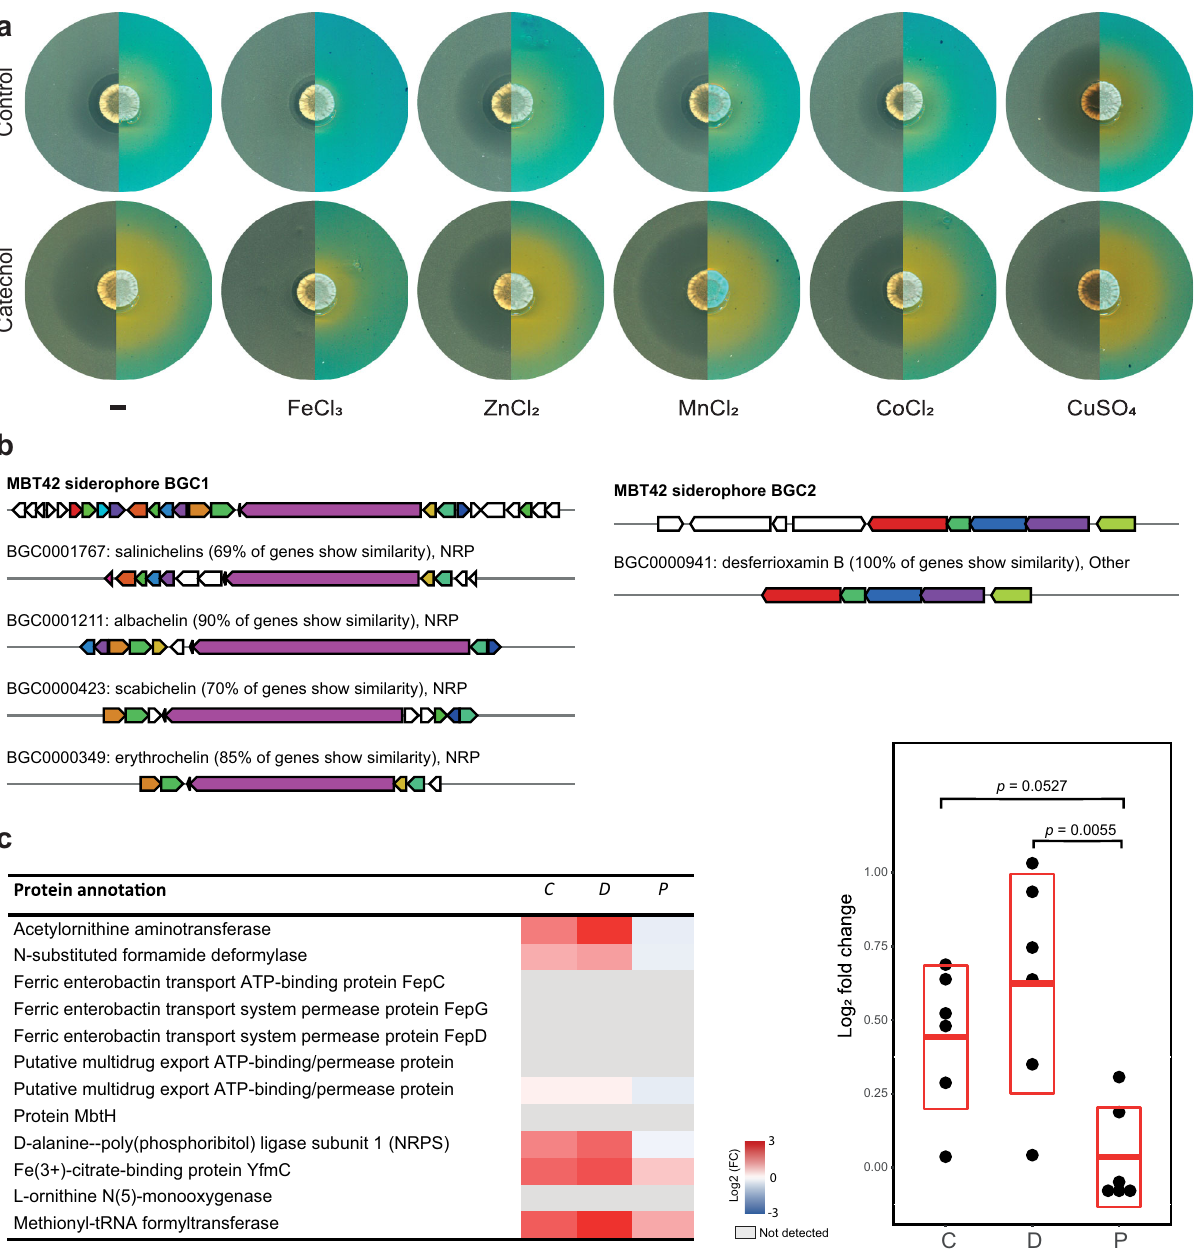
Fig. 2 Catechols elicit siderophore production by Streptomyces sp. MBT42. a Streptomyces sp. MBT42 was grown on NA with and without 100 µ M catechol, supplemented with various metal salts (5 µ M) ( n = 3). After 4 days of growth, plates were overlaid with B. subtilis (left) to test for antimicrobial activity or with CAS agar to detect the extracellular production of iron-chelating molecules (orange halos; right). Note that catechol inhibits the growth of B. subtilis and induces siderophore production, and that these zones are highly comparable. When iron was added to the medium, siderophore production was almost completely inhibited and the semi-transparent halo was no longer visible. b Analysis using antiSMASH revealed two siderophore BGCs in the genome of MBT42. KnownClusterBlast output from antiSMASH which shows similar clusters from the MIBiG database. Genes marked with the same color are interrelated; white genes have no relationship. c Change in protein expression of the salinichelin-like BGC of Streptomyces sp. MBT42 in response to catechin (C), dopamine (D), and phenylephrine (P). The heatmap shows the log 2 fold change of protein level compared to control ( n = 4). Note the similarity between catechin and dopamine. The scatter plot shows the average log 2 fold change of each protein. The mean and standard deviation are indicated in red The average log 2 fold changes in protein level were compared between the different groups by one-way ANOVA, followed by a post hoc Tukey ’ s HSD